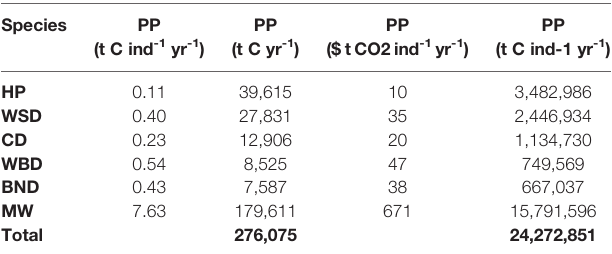
TABLE 5 | Cetacean driven primary productivity and valuations.